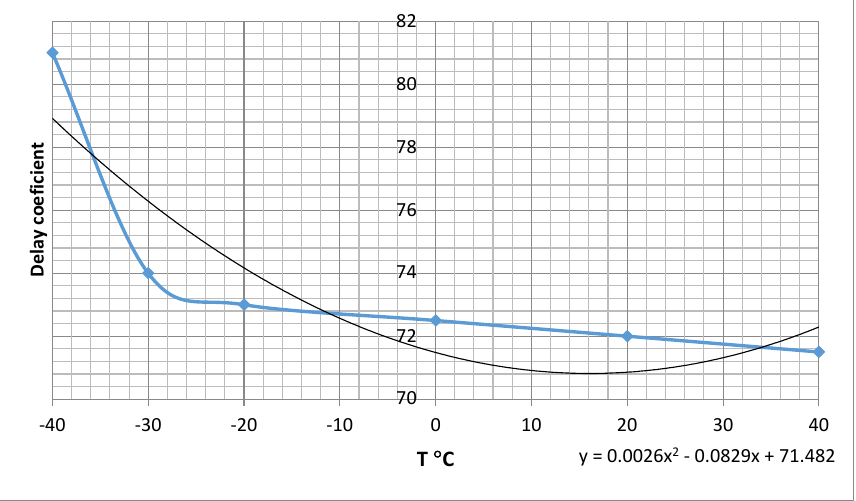
Figure 20 represents the dependency of parameter C temp on the outdoor temperature on the connection of a circuit breaker.